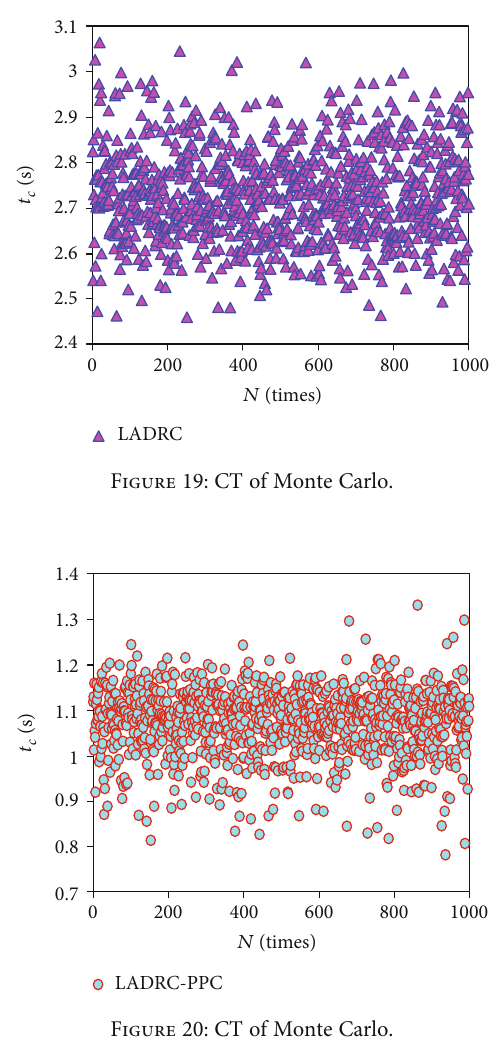
Figure 20: CT of Monte